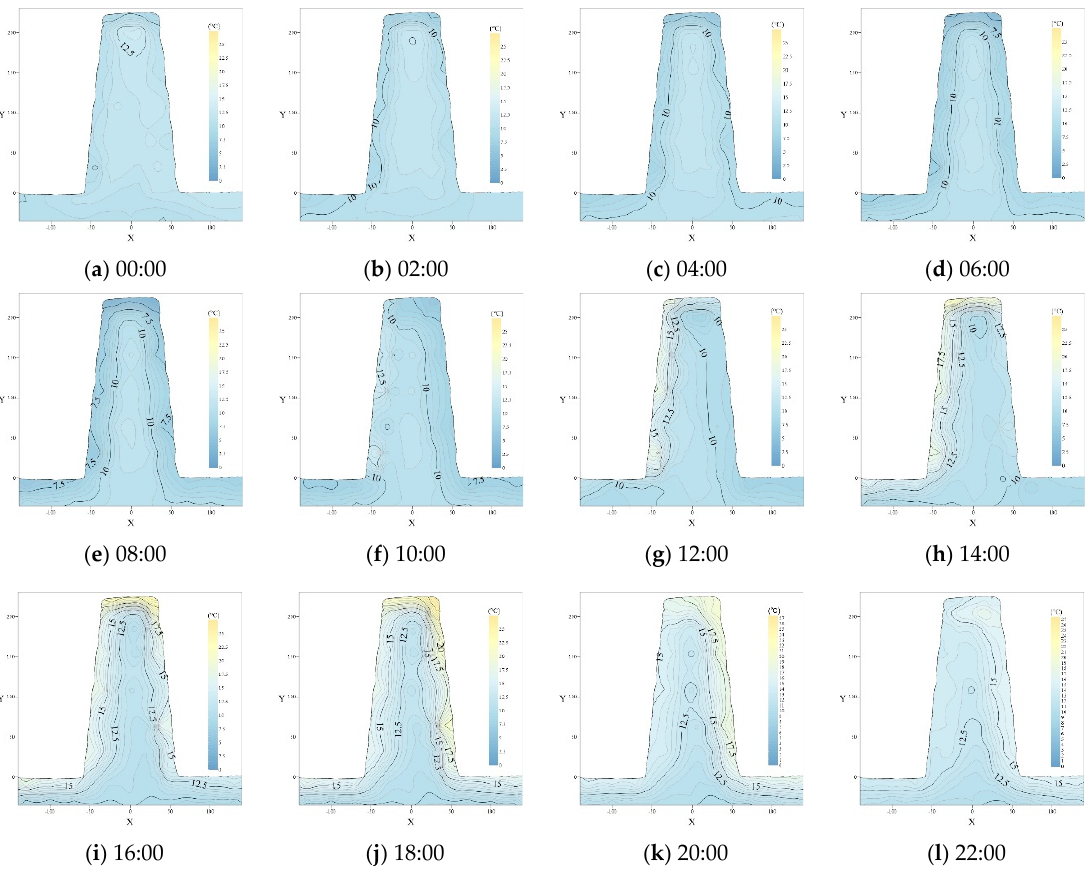
Figure 8. Temperature variations in the test wall on 22 March.